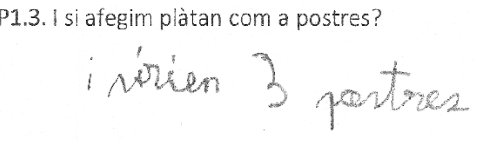
Figure 7. Incorrect answer of Q3. SPC1 error (translation: it would be three desserts).